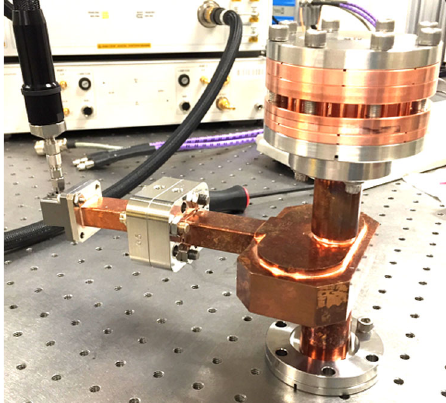
FIG. 17. The clamped HPBG structure with mode launcher under test at the VNA.